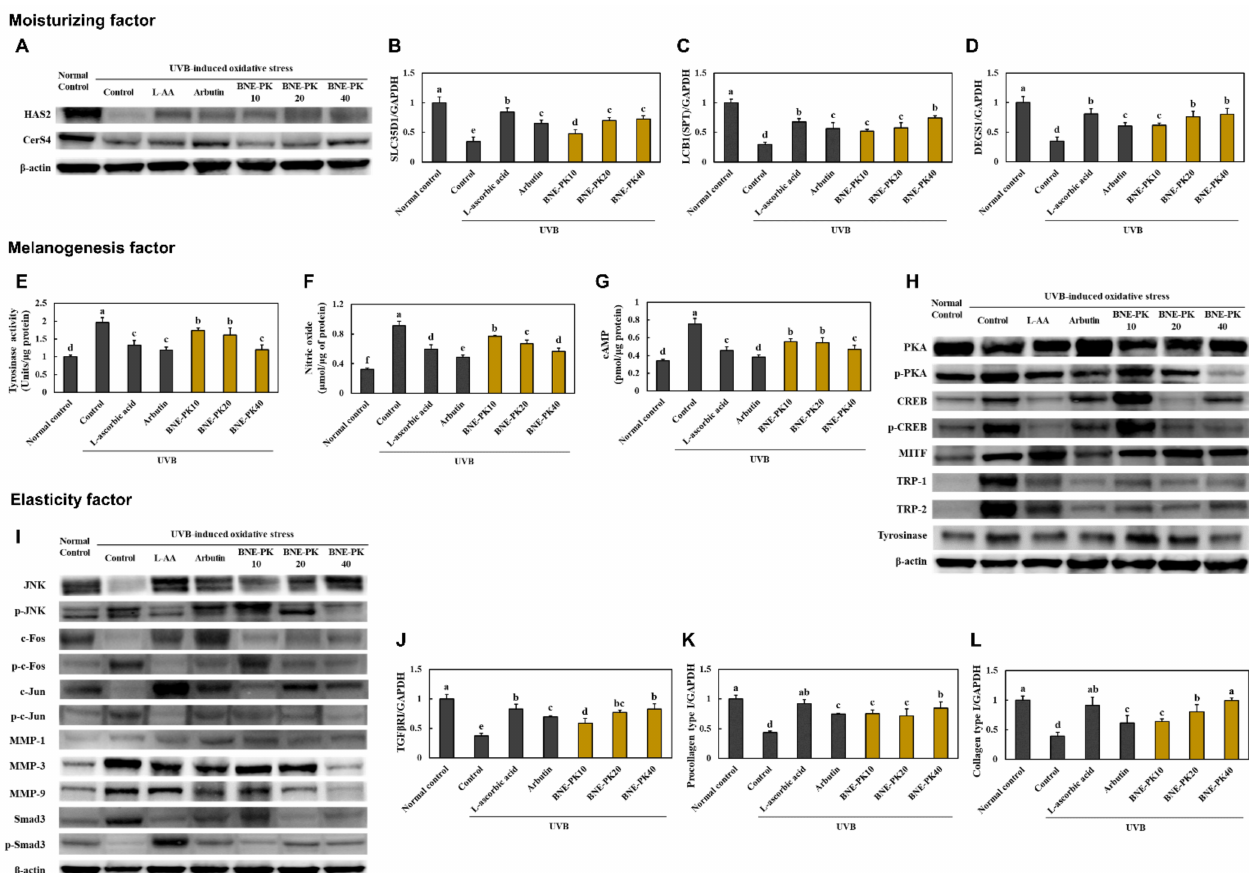
Figure 3. Effects of BNE-PK on protein expression of HAS2 and CerS4 ( A ), SLC35D1 mRNA ( B ), LCB1 mRNA ( C ), DEGS1 mRNA ( D ), tyrosinase activity, ( E ) nitric oxide ( F ), cAMP ( G ), PKA/CREB/MITF/TRP-1/TRP-2/tyrosinase pathway ( H ), JNK/c-FOS/c-Jun/MMPs/Smad3 pathway ( I ), TGF- β RI mRNA ( J ), procollagen Type I mRNA ( K ), and collagen Type I mRNA ( L ) in the dorsal skin of ultraviolet B (UVB)-irradiated hairless mice. Normal control ( − UVB), control (+UVB), L-ascorbic acid (positive control 1; +UVB with dietary supplementation of L-ascorbic acid at 200 mg/kg/body weight [bw]), arbutin (positive control 2; +UVB with dietary supplementation of arbutin at 200 mg/kg/bw), BNE-PK 10 (+UVB with dietary supplementation of BNE-PK at 10 mg/kg/bw), BNE-PK 20 (+UVB with dietary supplementation of BNE-PK at 20 mg/kg/bw), and BNE-PK 40 (+UVB with dietary supplementation of BNE-PK at 40 mg/kg/bw). Values are presented as mean ± SD. Different letters indicate a significant difference, with p < 0.05, as determined with Duncan’s multiple range